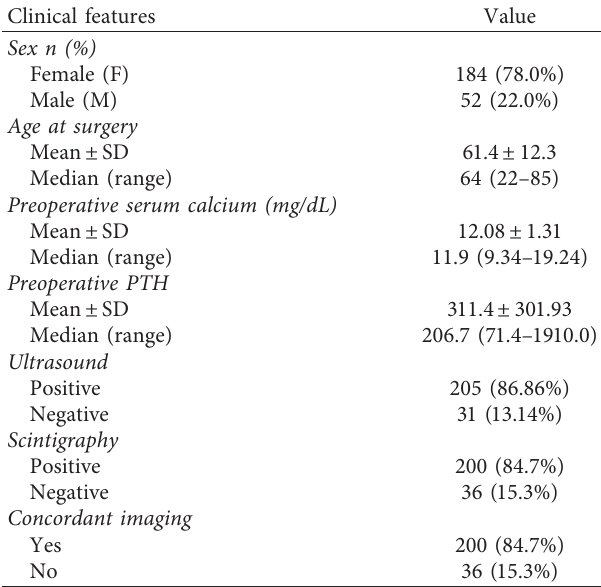
Table 5: Clinical features of patients with single-gland disease ( n �